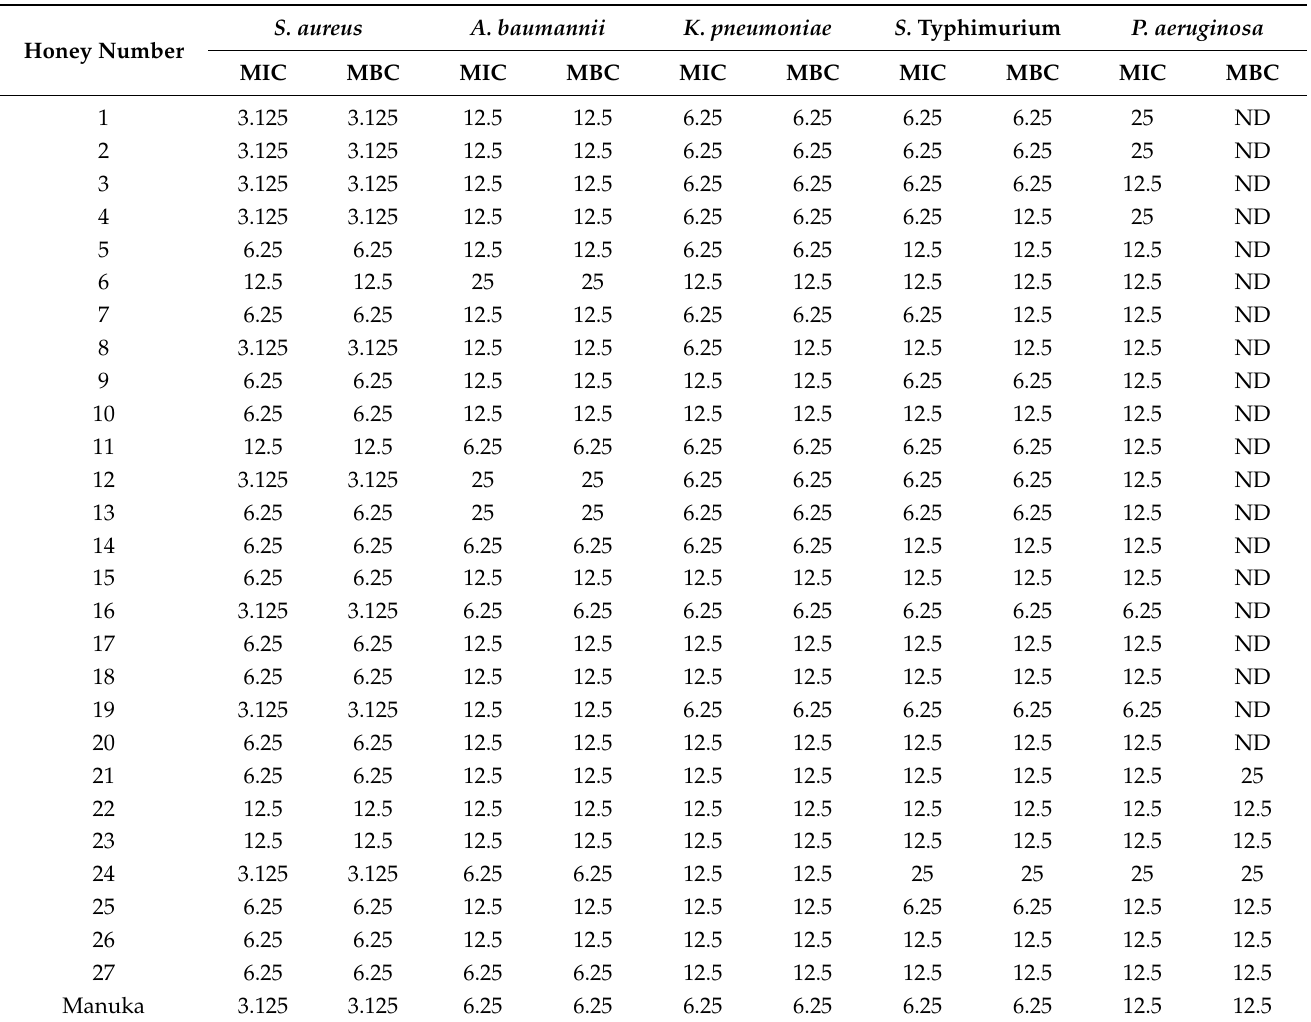
Table 2. Antibacterial activity of pine honeys ( n = 27) compared to manuka honey expressed as MIC and MBC